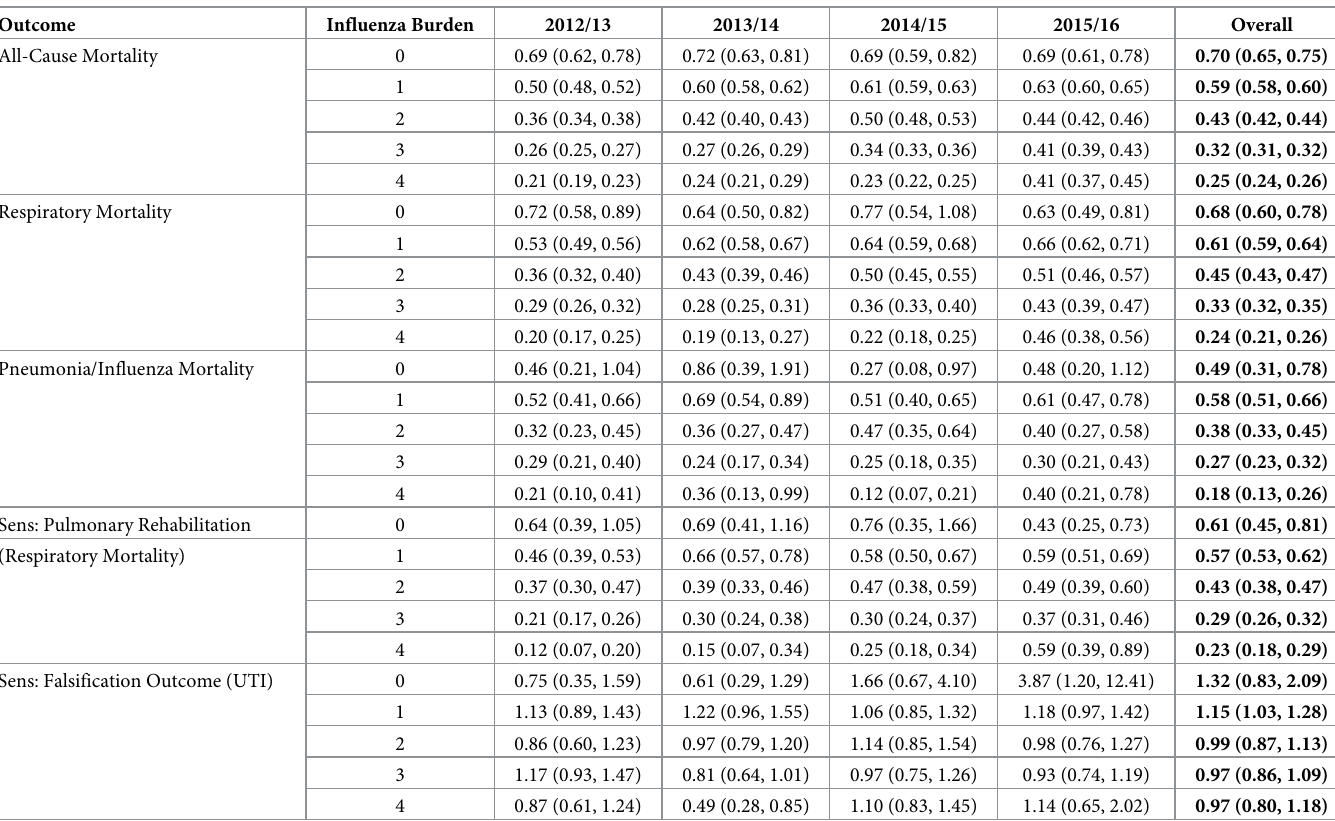
Table 3. Adjusted hazard ratio of influenza vaccination and mortality by influenza activity